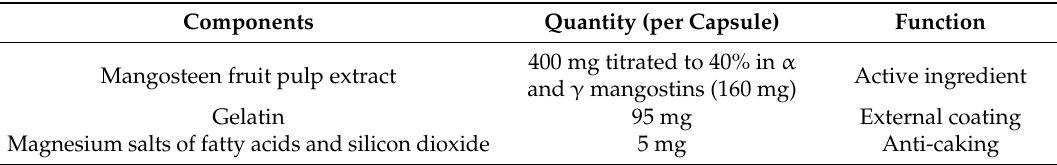
Table 1. Mangosteen supplement composition.